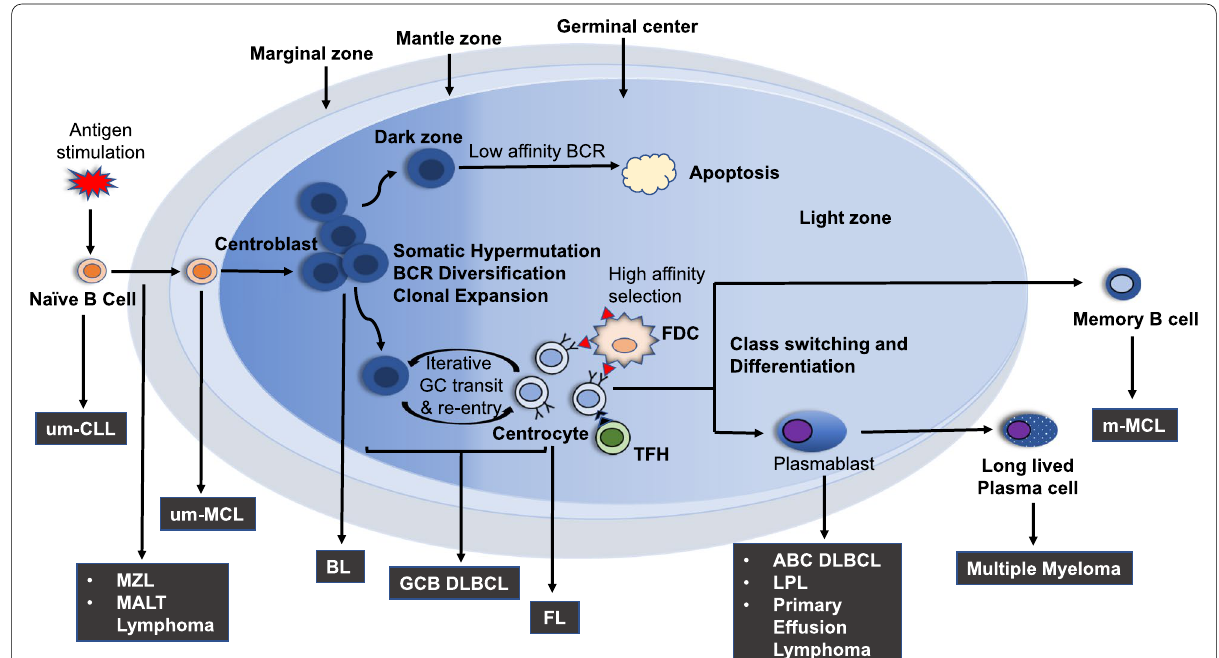
Fig. 1 B-cell ontogeny and differentiation in the lymph node germinal center and its major neoplastic equivalents during